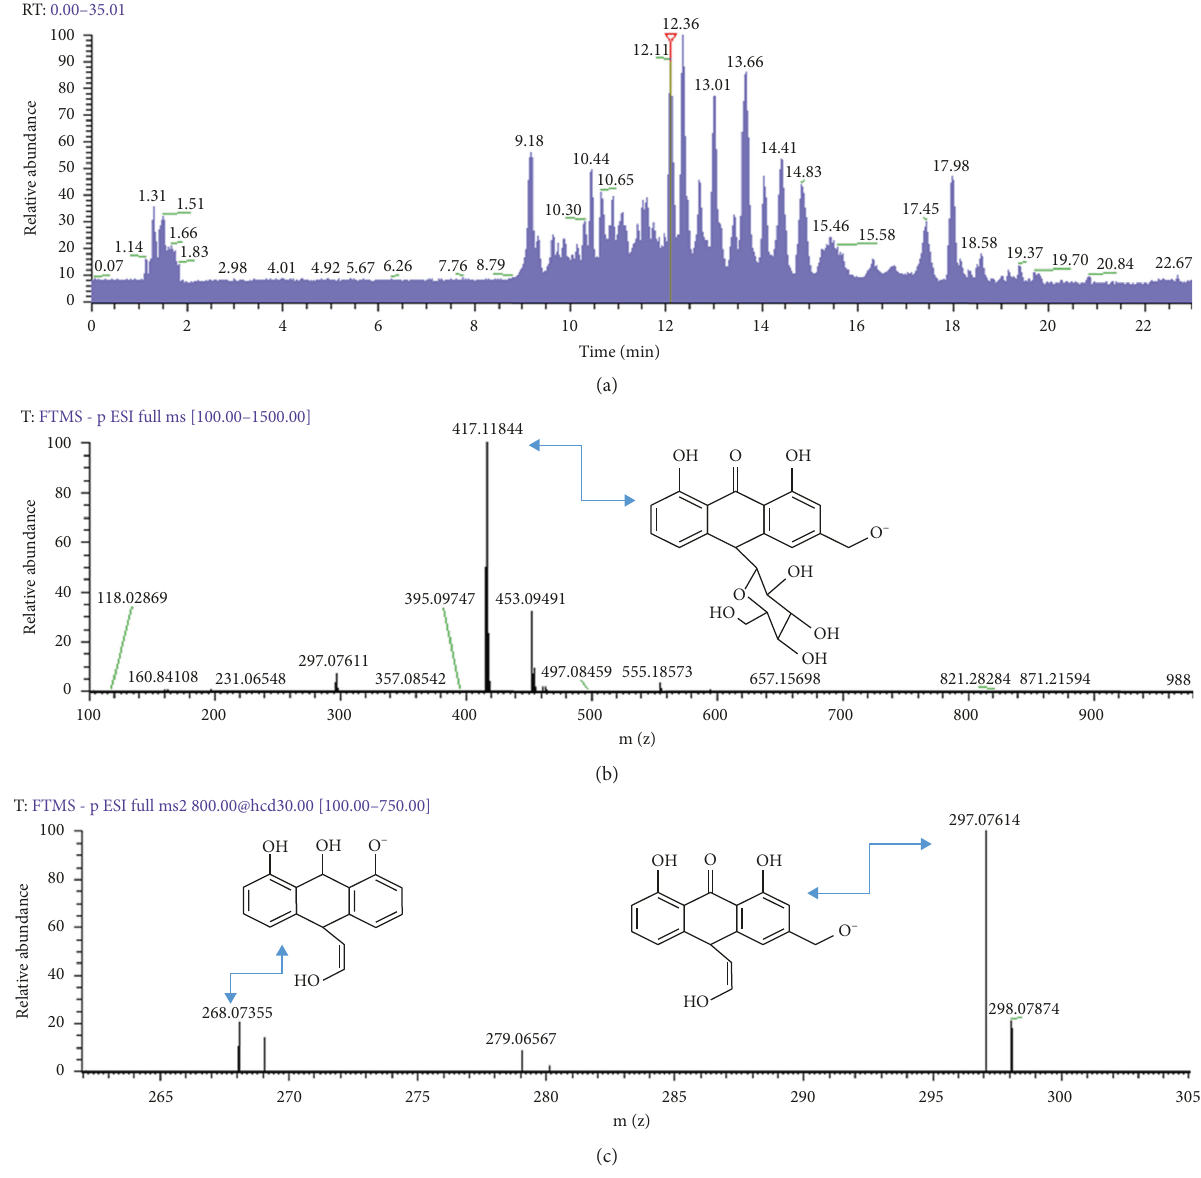
Figure 3: UHPLC chromatograms of A. vera peel: (a) TIC (total ion current, negative mode), (b) full high-resolution mass spectra showing the ion aloin A, and (c) fragmentation